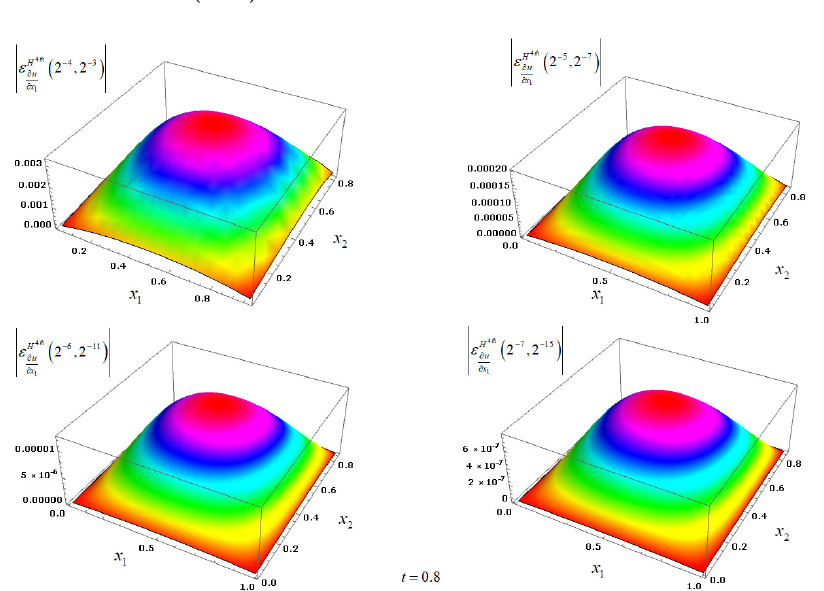
(cid:16) (cid:17) ∂ u for ∂ x 1